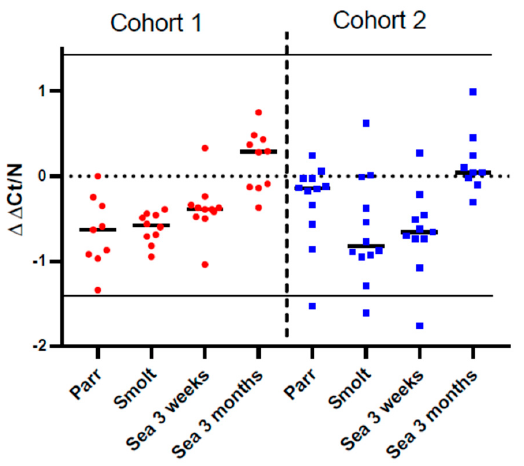
Figure 3. Mean deviations of immune gene expression in the gill from the gill reference data set (GRDS). Data are normalized so that the mean of each gene in the entire data set is zero (dotted line). Each mark corresponds to an individual (n = 9–12). Solid lines mark 2 σ thresholds.